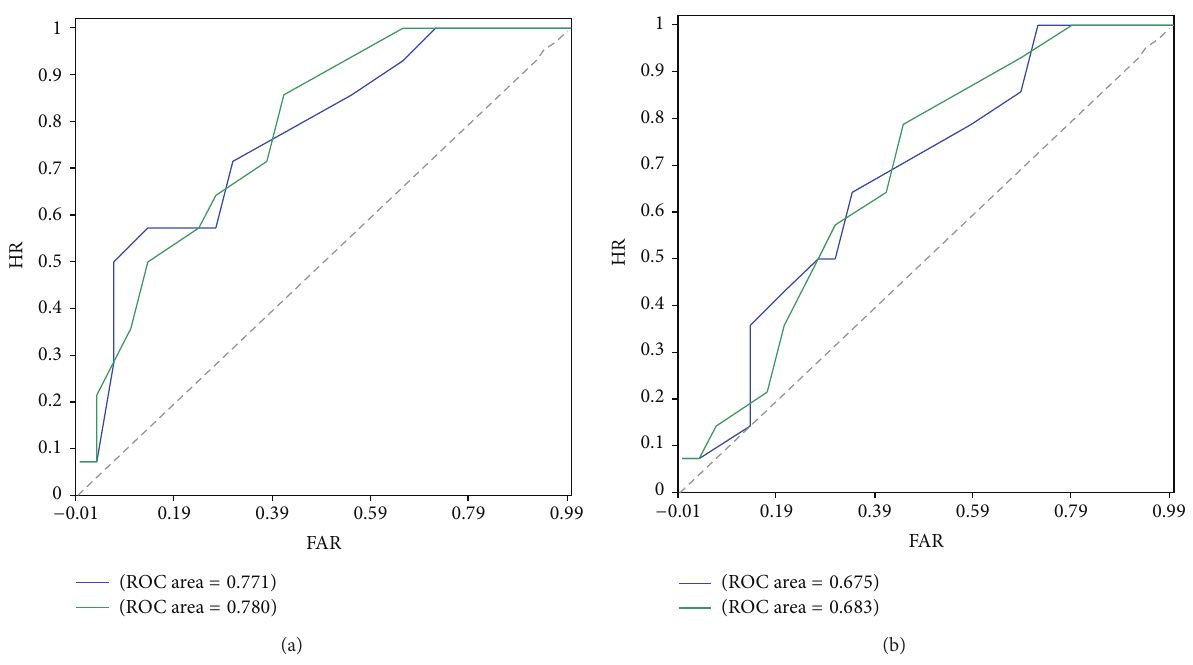
Figure 2: ROC curves of February (4-5) forecasts for UT categories using the DEMETER-3 ensemble over northern Pakistan for the period of 1959–2001 and validated against (a) observations and (b) ERA-40. Blue and green lines represent uncorrected and bias-corrected skills,